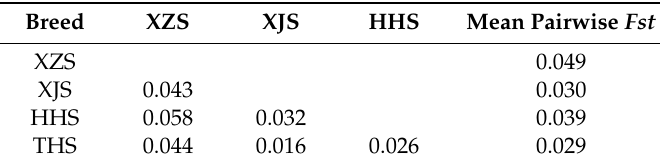
Table 2. Fst / (1-Fst) values between pairs of four goat populations.